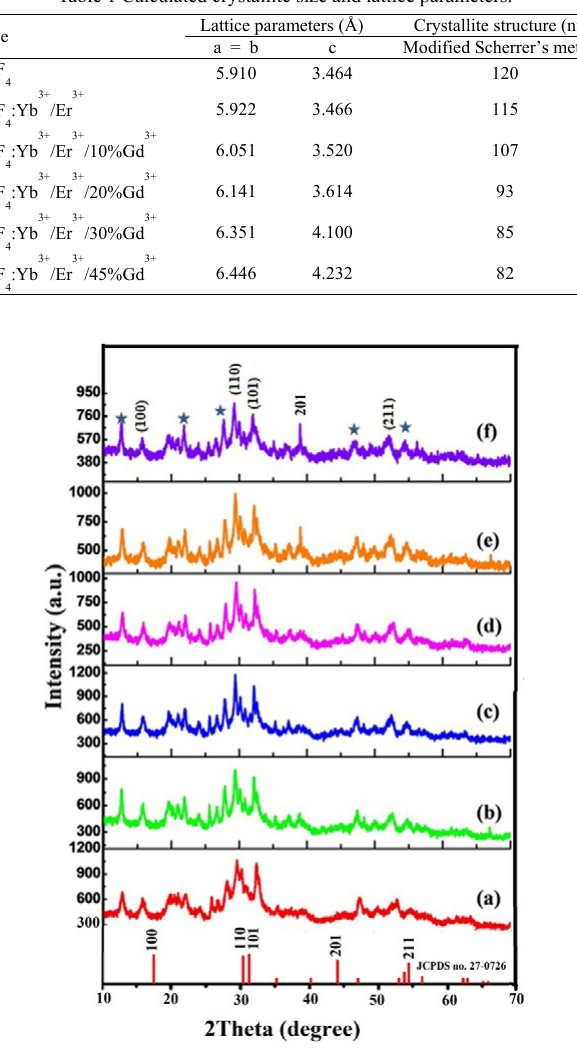
Fig. 1 PXRD patterns for (a) undoped and 20%Yb 3+ /2%Er 3+ doped NaLuF nanocrystals with different Gd 3+ contents: (b) 0% (c) 10% (d) 20% (e) 30%